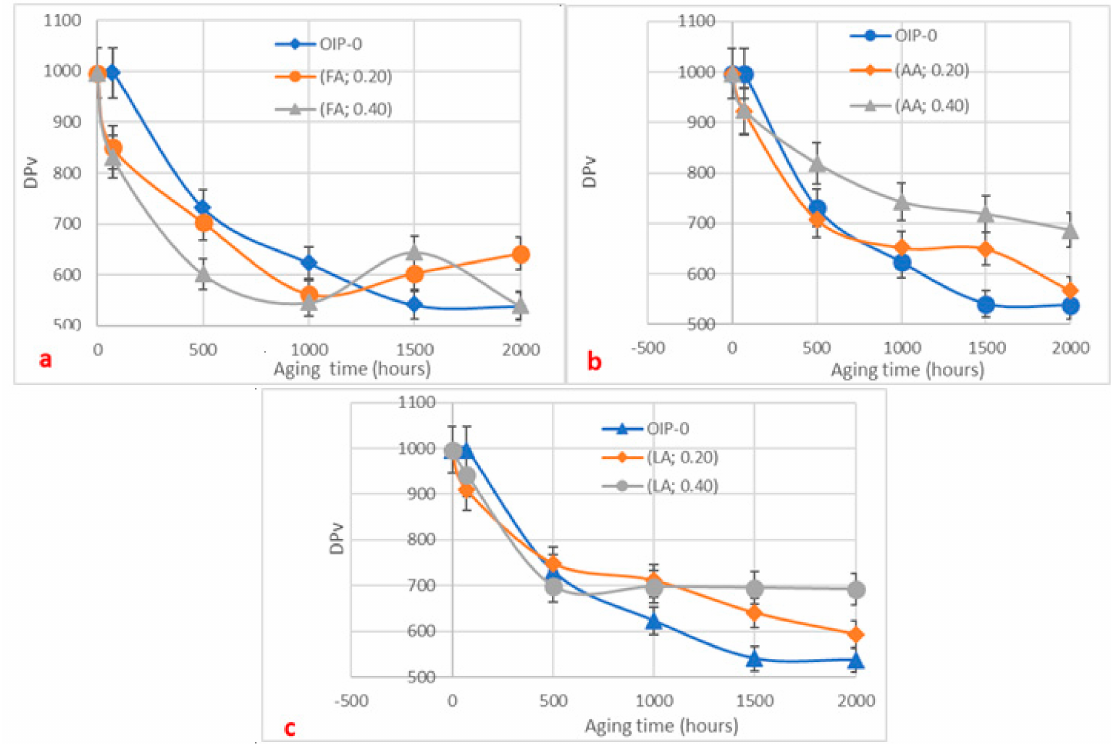
Figure 5. Fall in degree of polymerization (DPv) of paper during aging, for paper samples aged in oil mixed with three different acids (formic, acetic and levulinic) and virgin oil: ( a ) 0.20 mg KOH/g and ( b ) 0.40 mg KOH/g for three different acids (formic, acetic and levulinic), acid mixture and also for acid-free oil. The results are summarized in Figure ( c ) for better